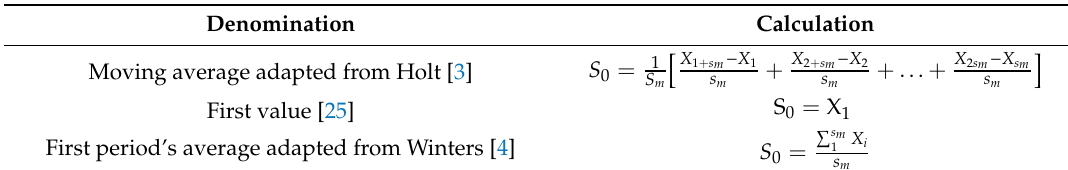
Table 2. Proposed methods and the method published in [25] for obtaining the initial value of the level in multiple-seasonal